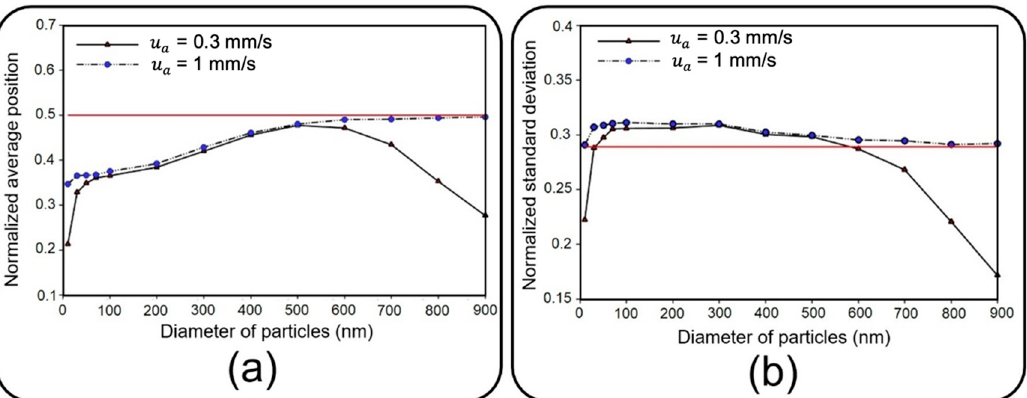
Figure 10. Normalized ( a ) average position and ( b ) standard deviation of deposited NPs of diameter ranging from 10 nm to 900 on the substrate of the air channel with pore diameter and pore to pore distance of 10 µm under two different fluid velocities of 0.3 mm/s and 1 mm/s. The solid red line corresponds with an ideal deposition.